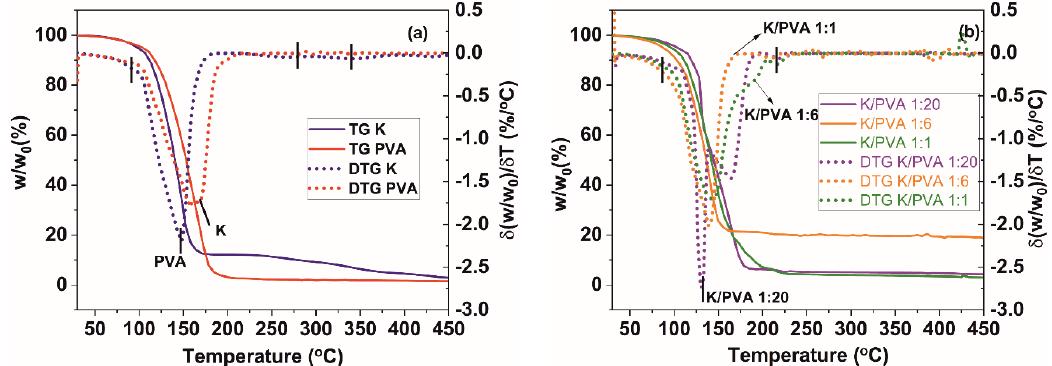
Figure 5. TGA and DTG thermograms of ( a ) PVA and CAR; ( b ) PVA/CAR mixtures.